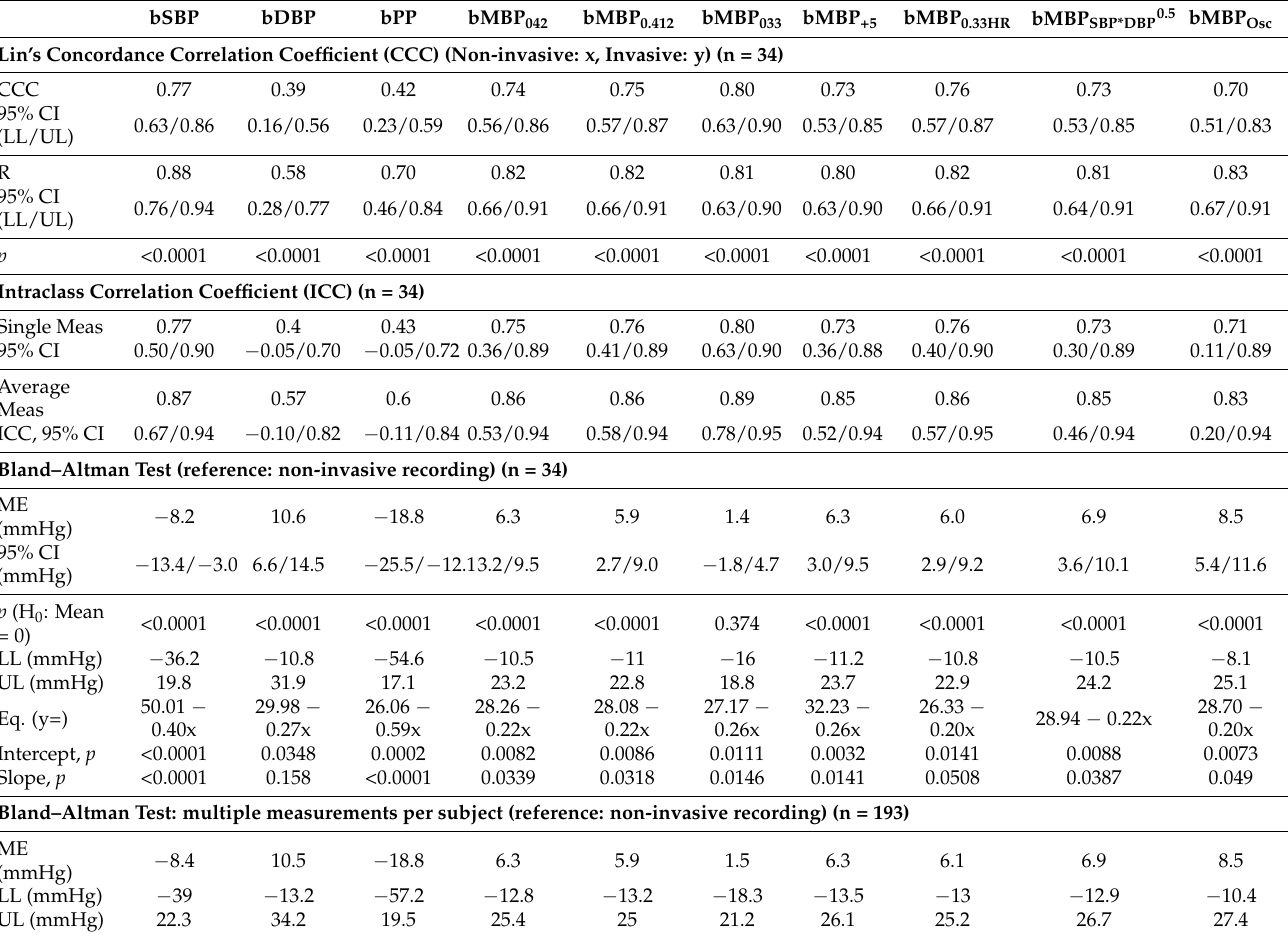
Table 4. Comparison of invasive and non-invasive (oscillometry) brachial blood pressure